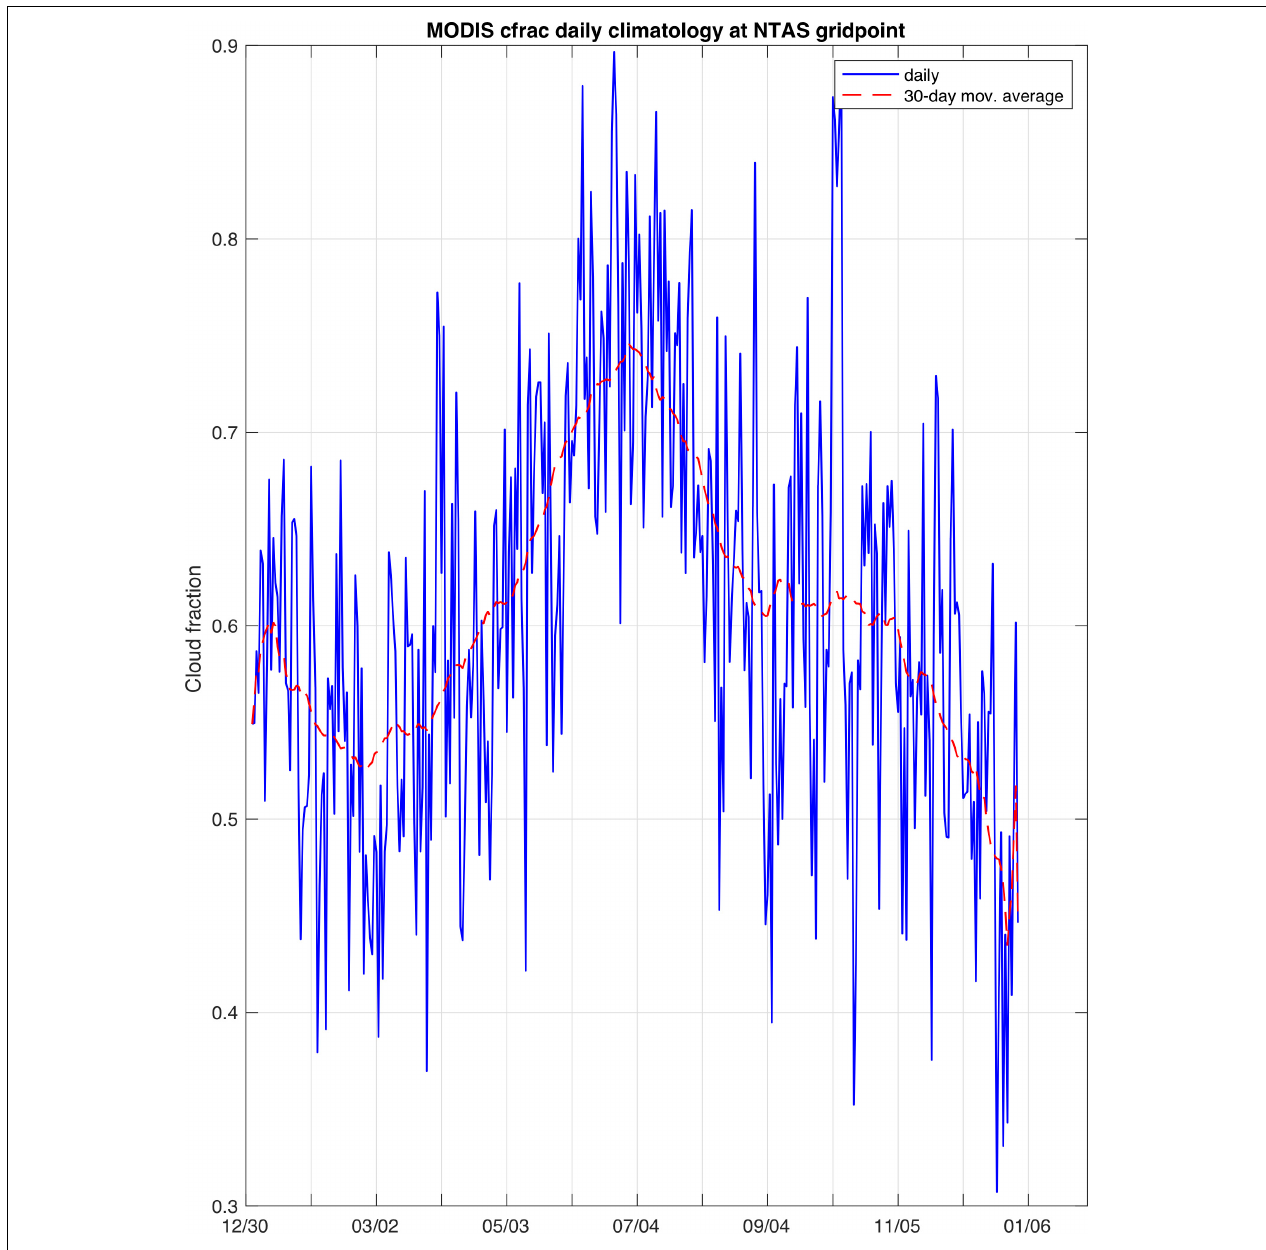
FIGURE 10 | Daily cloud fraction at NTAS, based on MODIS data for period 2001 to 2012.